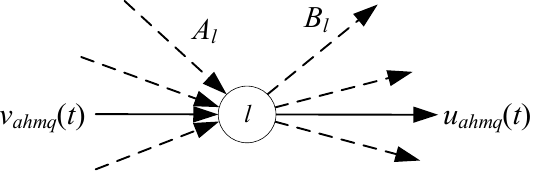
Figure 4. FCC at common node l excluding origin r and destination s of vehicle m .